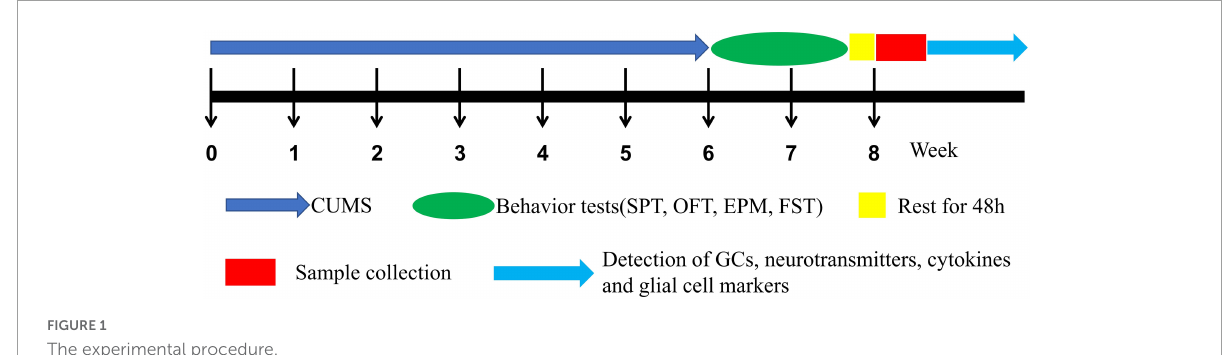
FIGURE1 The experimental procedure.